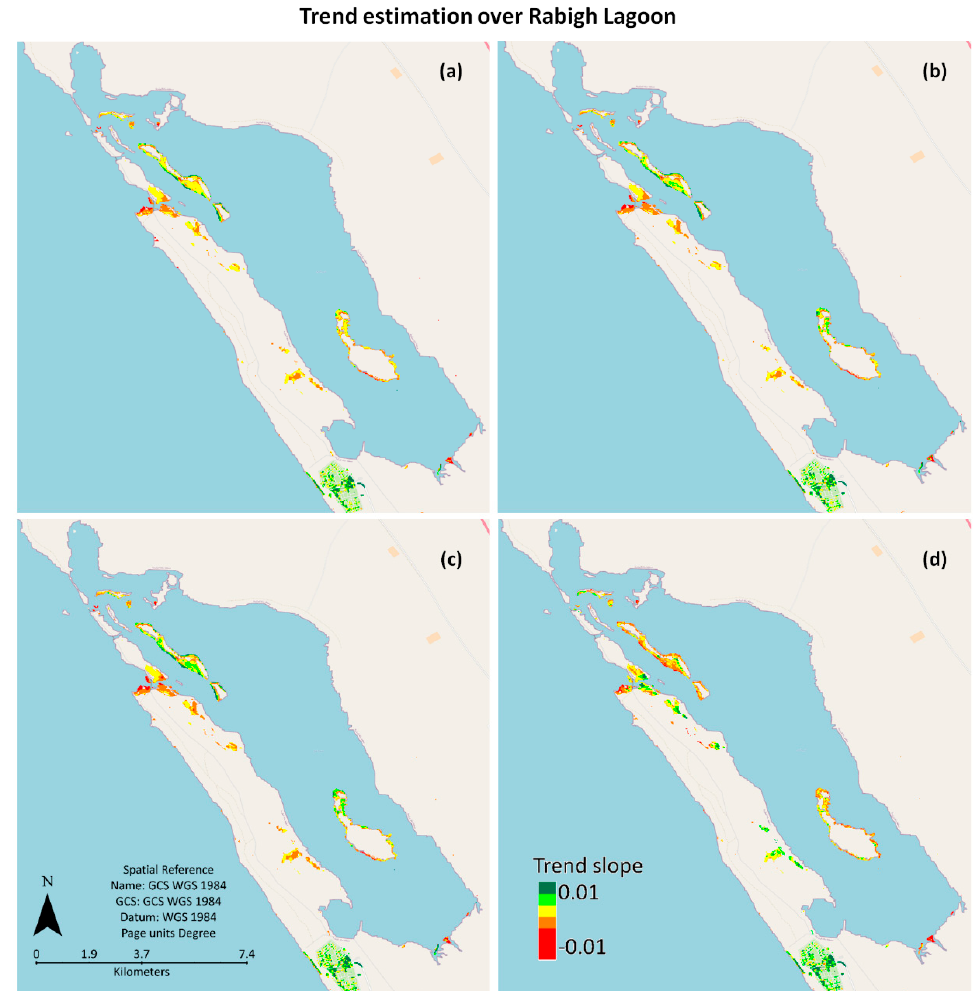
Figure 4. Regression slopes derived from the trend algorithm for ( a ) EVI, ( b ) MSAVI, ( c ) NDVI, and ( d ) NDMI. Forests 2021 , 12 , x FOR PEER REVIEW